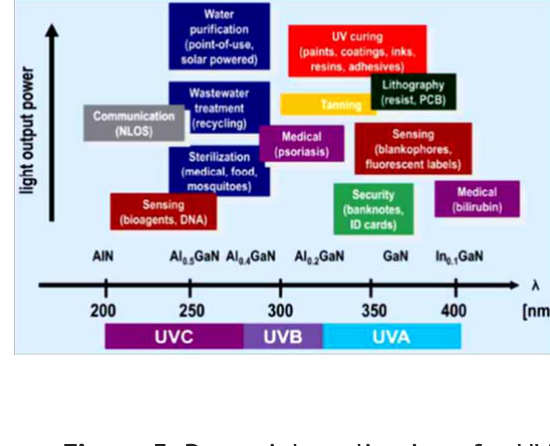
Figure 5. Potential applications for